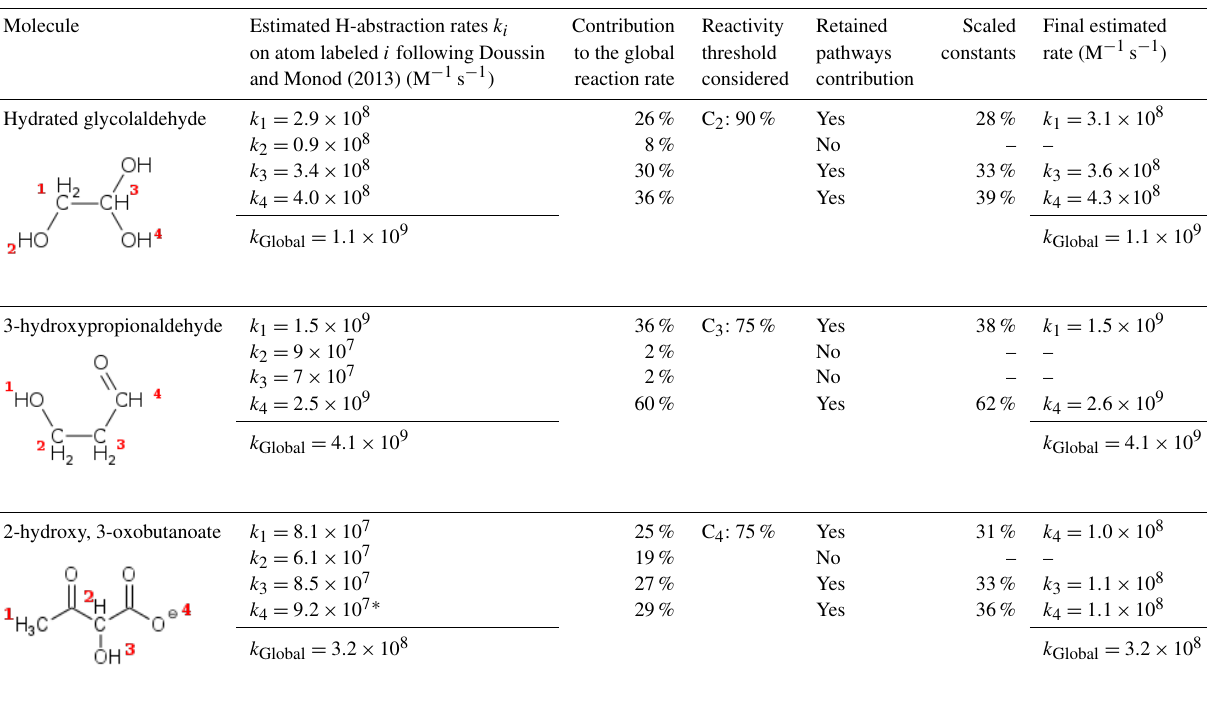
(*) electron transfer reaction